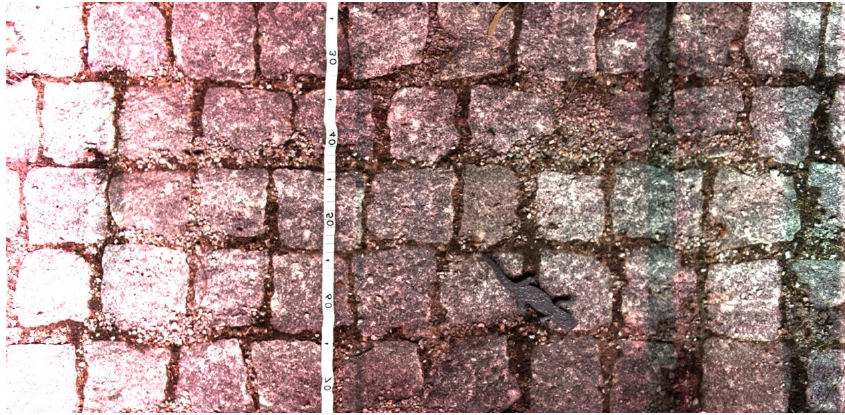
Figure 14. Scanned 3D model of an amphibian on a cobblestone road.